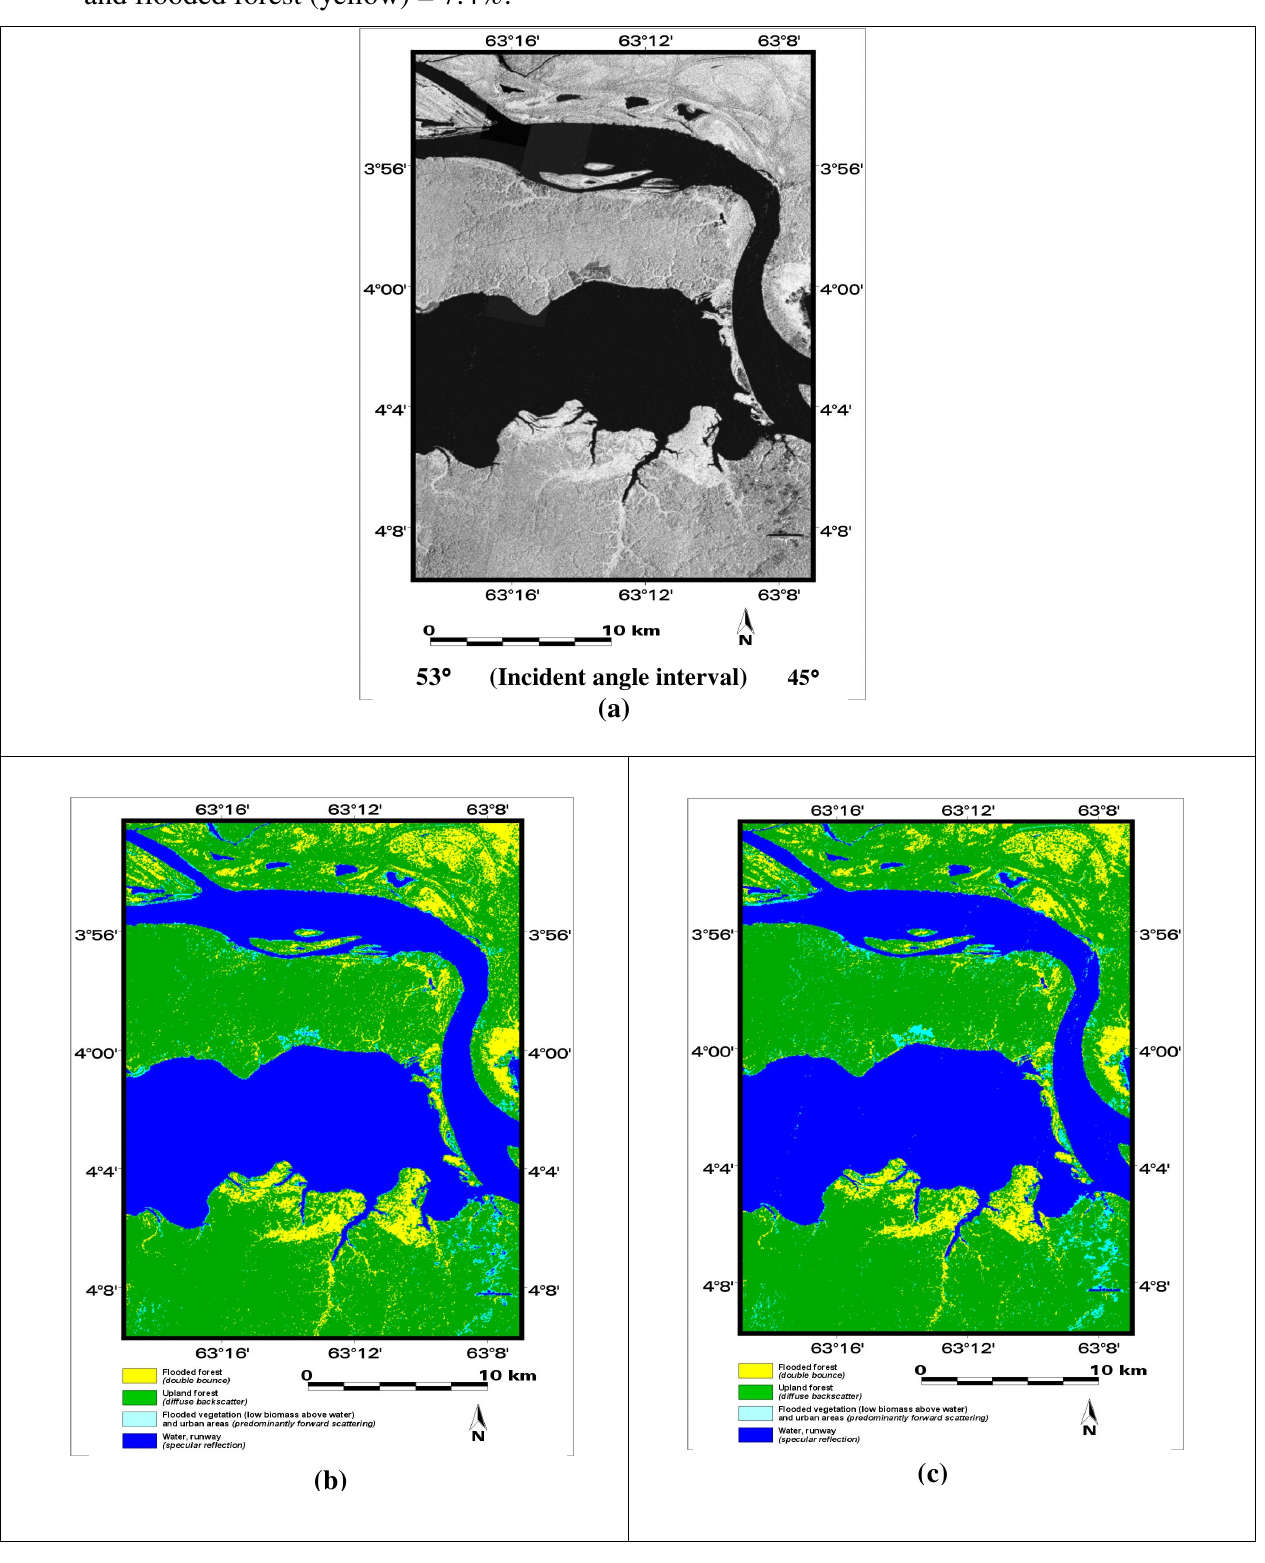
Figure 11. (a) Simulated LHH MAPSAR image; (b) USTC classification of simulated LHH MAPSAR image: pixels are labeled as water (blue) = 34.8%, flooded vegetation (cyan) = 2.4%, upland forest (green) = 54.1%, flooded forest (yellow) = 8.7%; and (c) USTC classification result of simulated LHH+LHV MAPSAR images: pixels are labeled as water (blue) = 34.7%, flooded vegetation (cyan) = 3.2%, upland forest (green) = 54.7 % and flooded forest (yellow) =